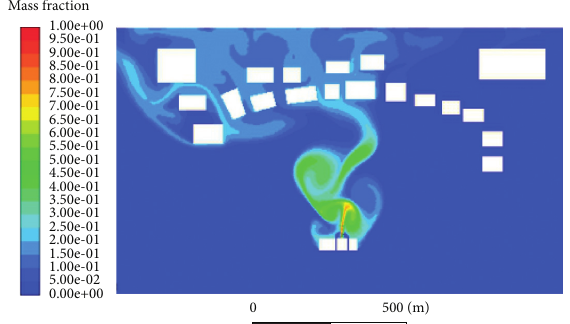
Table 7: Radiation dose of floating platform staff within 2 hours after LOCA (unit: